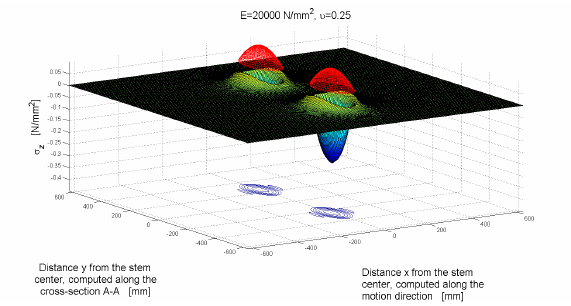
Figure 40: 3-D surfaces and stress contours of σ z near the surface for the interaction model of Figure 38 (second order